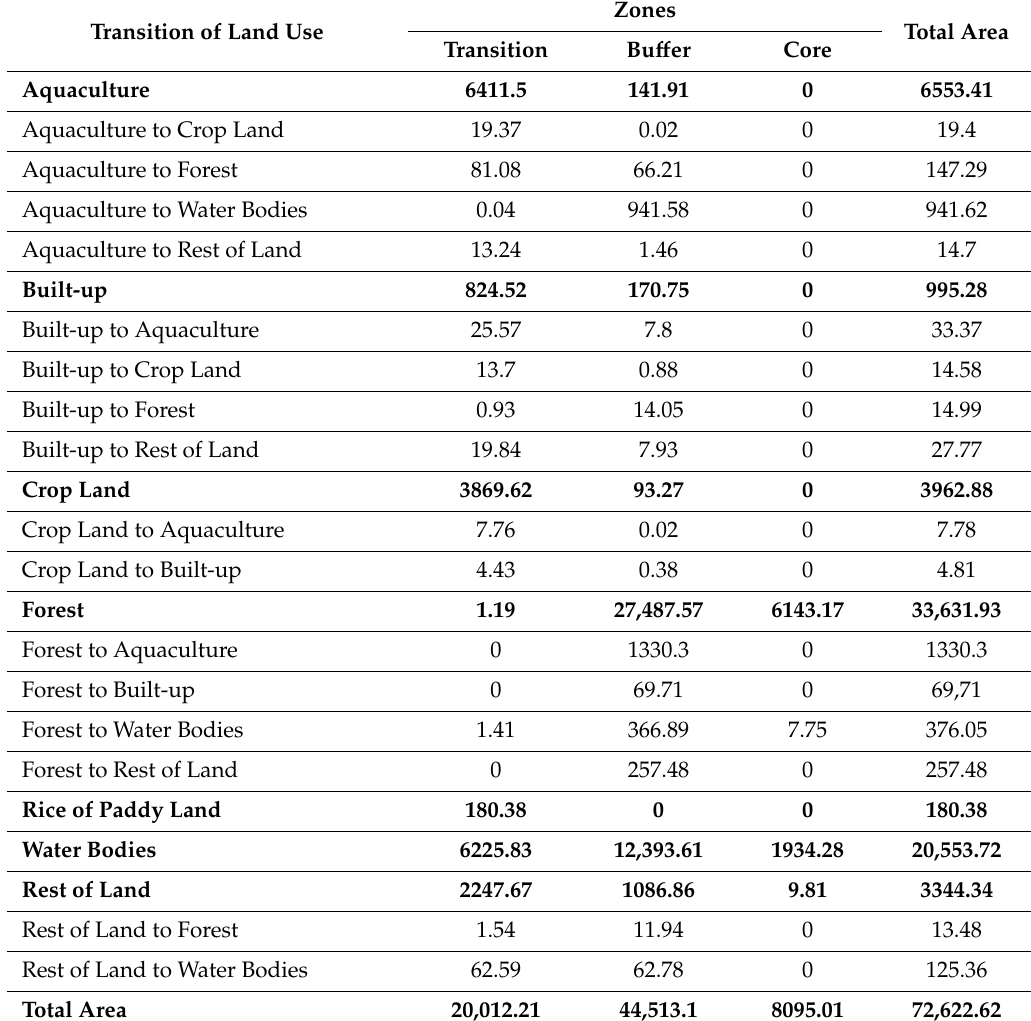
Table 7. The pattern of mangrove forest area followed the land use changes between 2015 and 2019